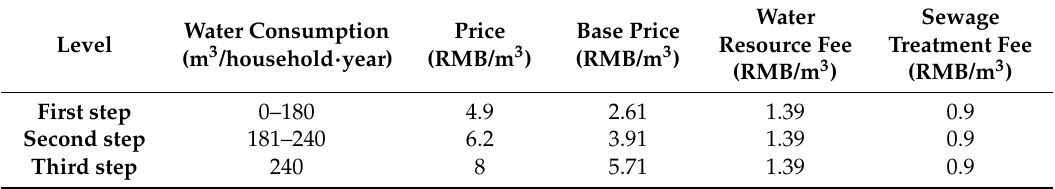
Table 3. Tianjin domestic water ladder price 1